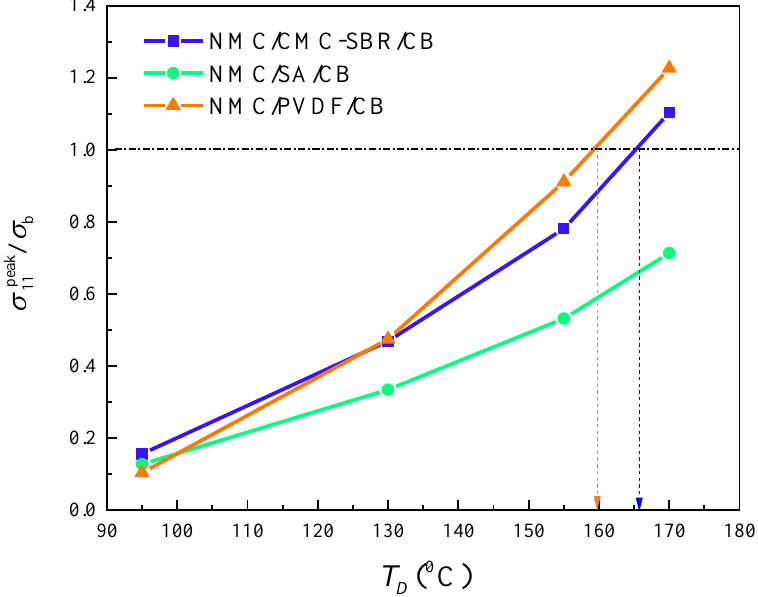
Figure 8. Effect of drying temperature on mechanical integrity of dried electrode coating with dif-